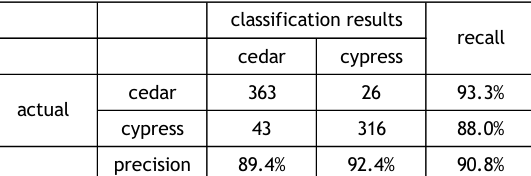
(e)Depth, Kmax and Kmin images with CNN and SVM